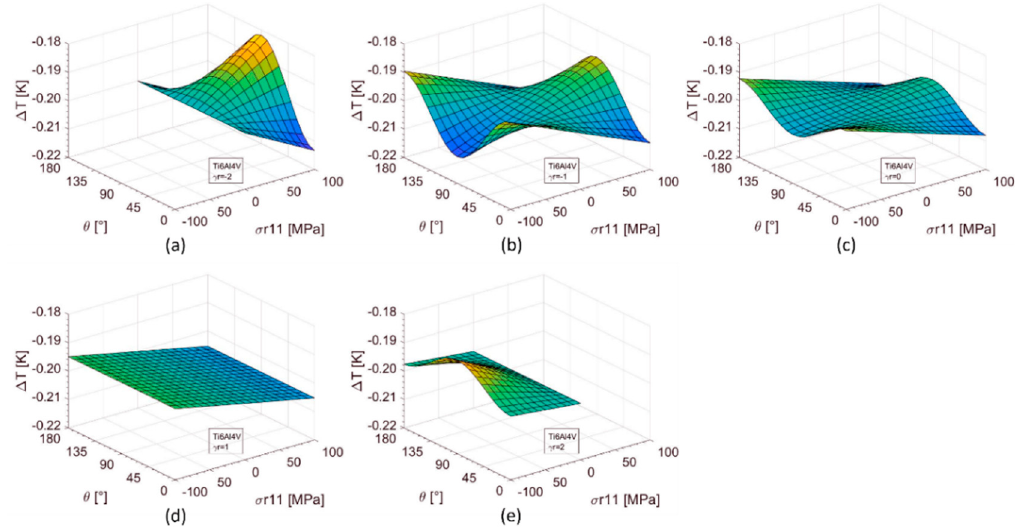
Figure 4. Thermoelastic signal as a function of the two independent variables σ r11 and θ for the Ti6Al4V alloy: ( a ) γ r = − 2 ( b ) γ r = − 1 ( c ) γ r = 0 ( d ) γ r = − 1 ( e ) γ r = − 2.